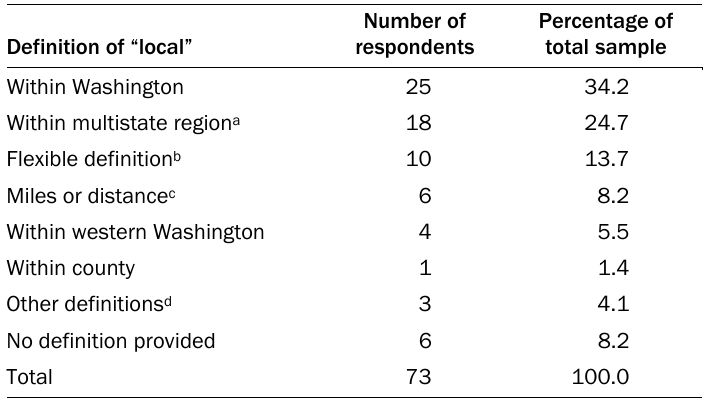
Table 2. Commercial Bakers’ Definitions of “Local” in Relation To Purchasing